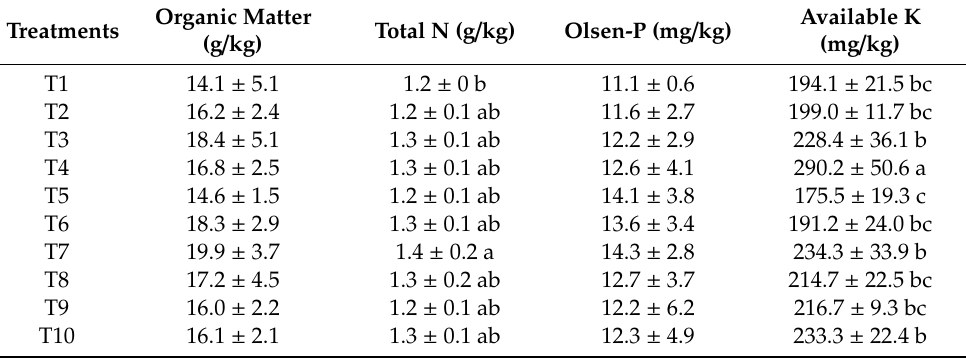
Table 5. The contents of organic matter and mineral nutrients in soils under di ff erent